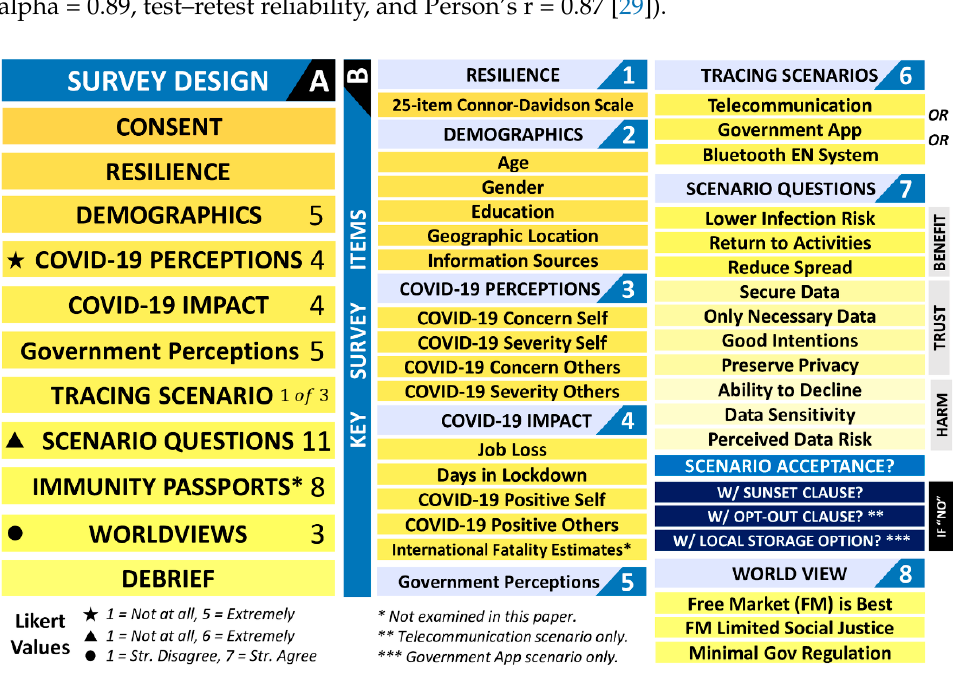
Figure 2. ( A ) The survey order, the number of items in each item-block (right), and associated Likert response options and values (bottom). ( B ) A break-down of the key items in this paper. Additional acceptance items are presented in navy blue for those participants who responded ‘no’ to the scenario acceptance item.